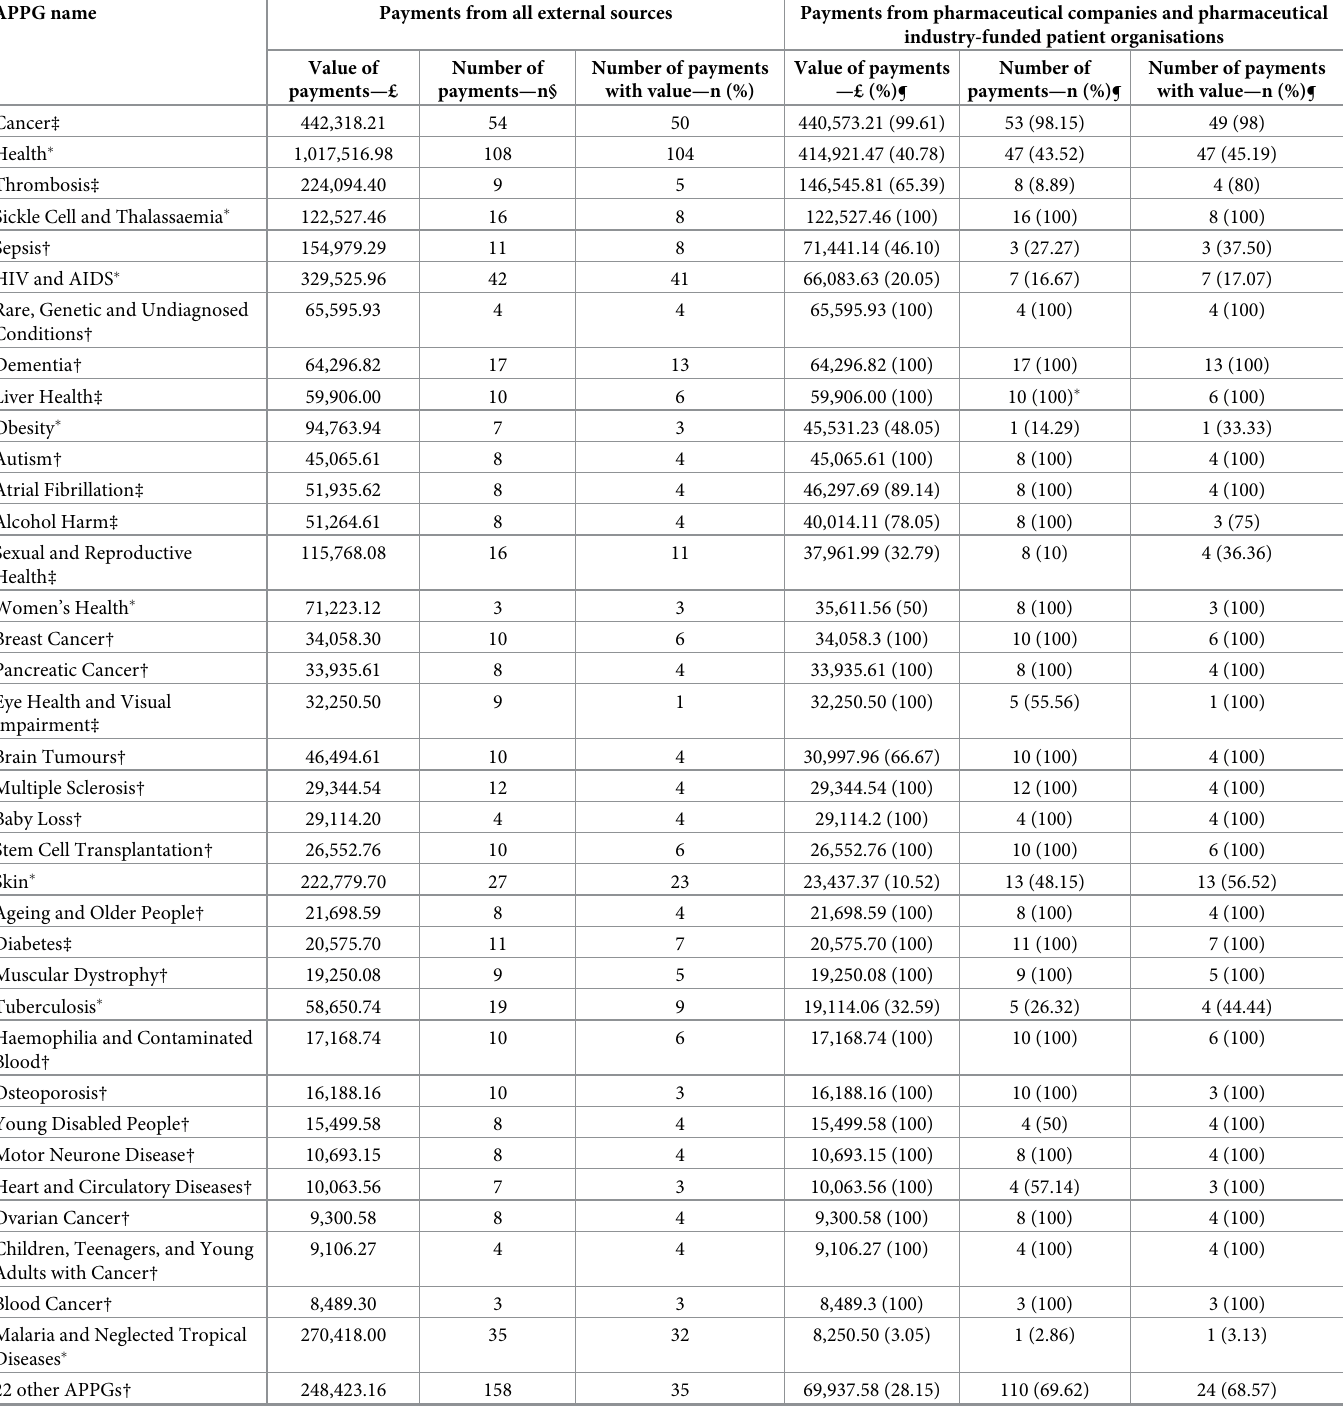
Table 1. Overview of all payments received by health related APPGs between